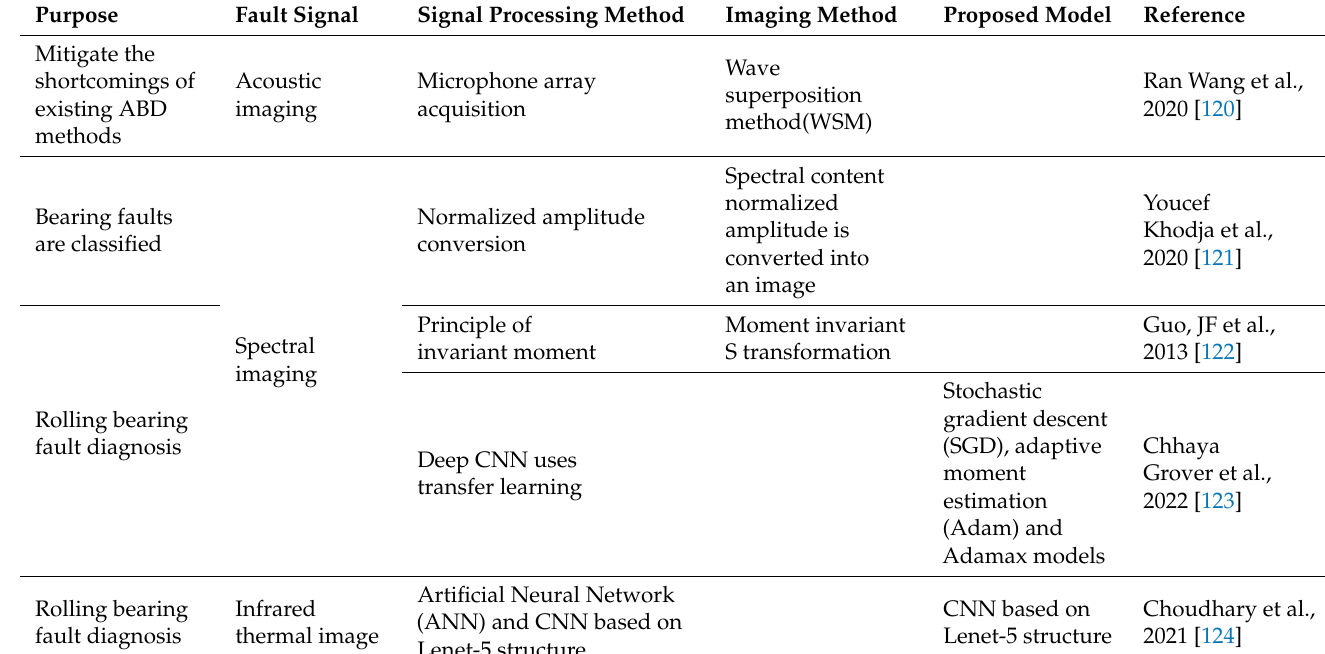
Table 13. Summary and comparison table of other two-dimensional-image